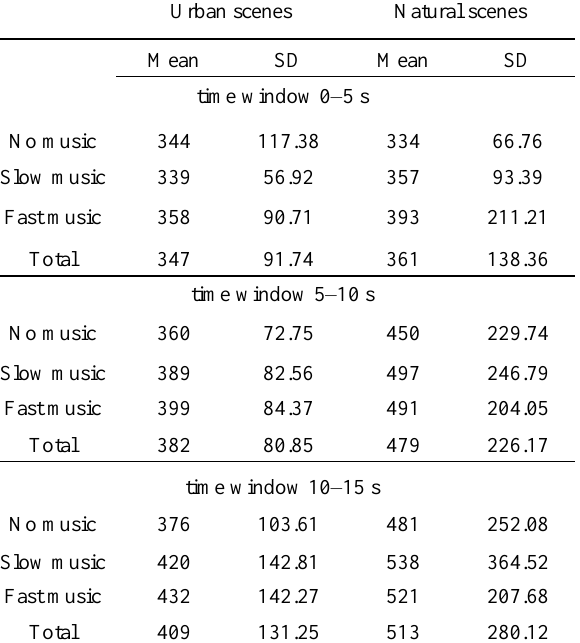
Table 2. Mean scores for the fixation durations in milliseconds for particular experimental conditions measured in the three time windows over the course of visual stimulus presentation: 0–5 s, 5–10 s, and 10–15